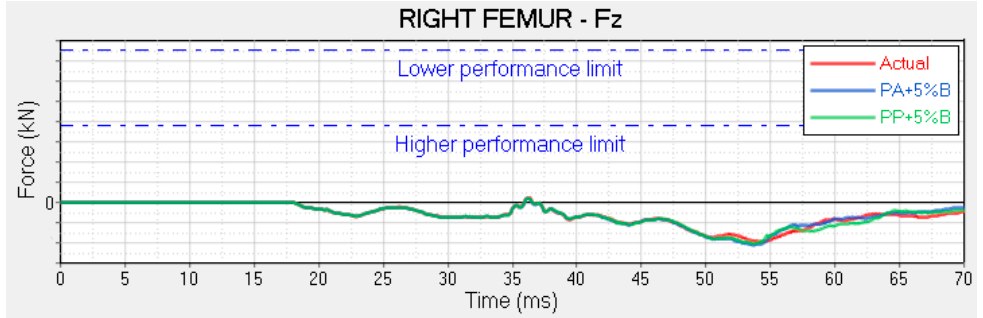
Figure 9. Load on the right femur.